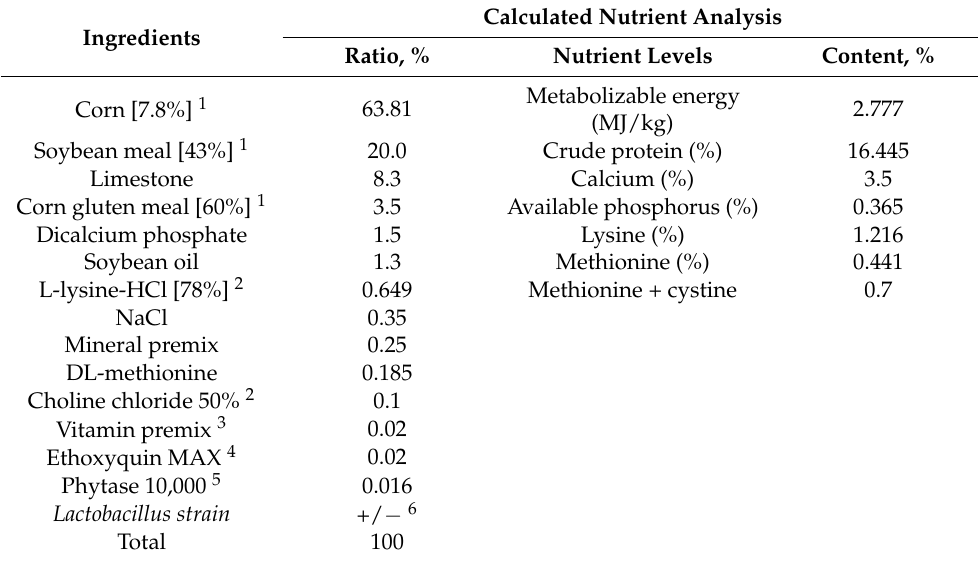
Table 1. Composition and nutrient levels of the basal diet (air-dry basis,